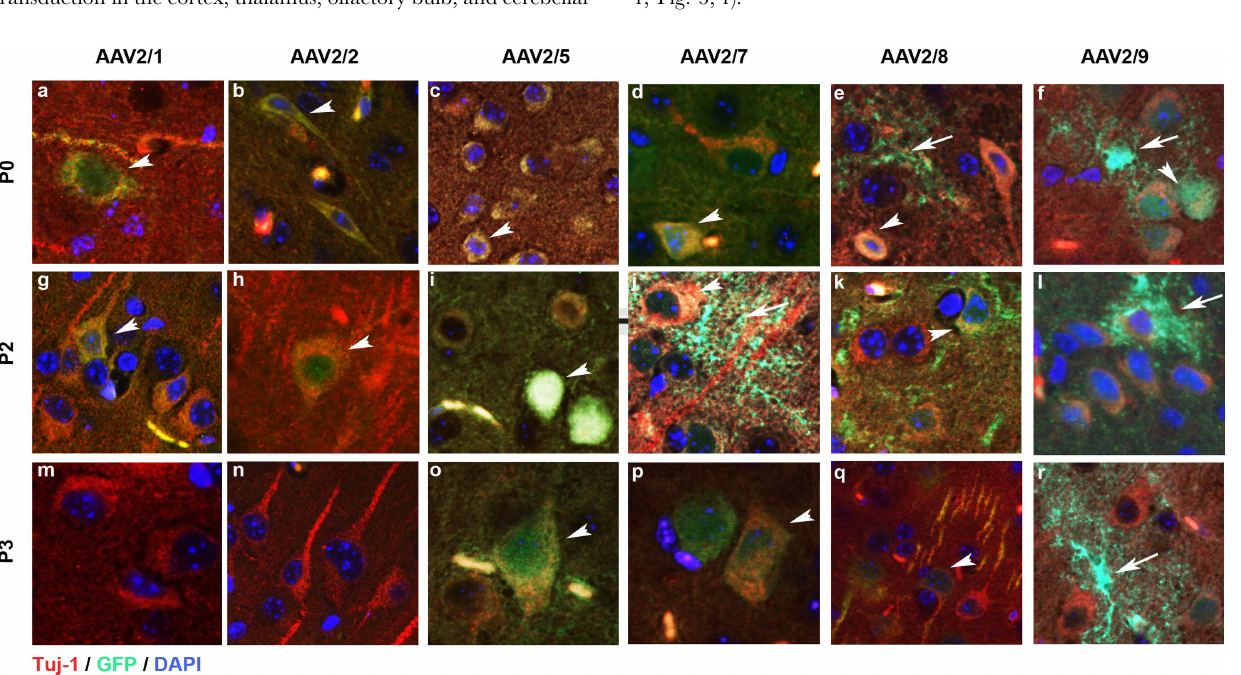
Figure 4. AAV2/n-EGFP tropism for neurons following intracerebrovcentricular delivery in neonatal mice. Representative tricolor merged fluorescent photomicrograph from 3-week-old wild type mice injected on neonatal day P0, P2 or P3 with pseudotyped AAV2/n. Paraffin embedded brain sections were co-labeled with anti EGFP antibody (488 nm-green), anti b -tubulin (568 nm-red) and DAPI counterstain (blue). Images were scanned from the cortex of mice injected at P0 (a-f), P2 (g-l) or P3 (m-r) with AAV2/1 (a,g,m), AAV2/2 (b,h,n), AAV2/5 (c,i,o), AAV2/7 (d,j,p), AAV2/ 8 (e,k,q) and AAV2/9 (f,l,r). Arrowhead, EGFP expressing neuron; arrow, EGFP expressing astrocyte. n=3–4/serotype/time of injection. Magnification